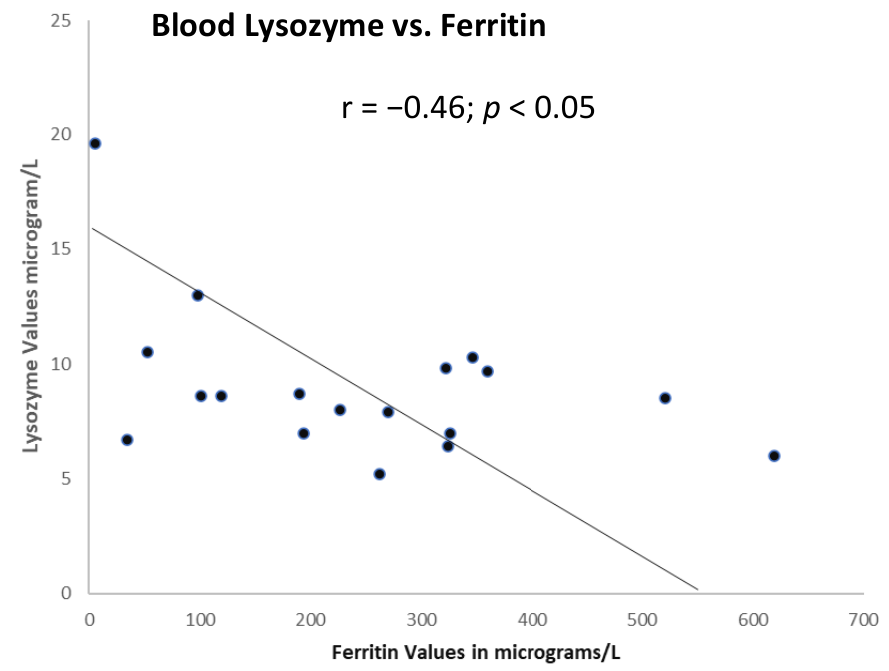
Figure 5. Significant correlation between lysozyme and ferritin in the serum.